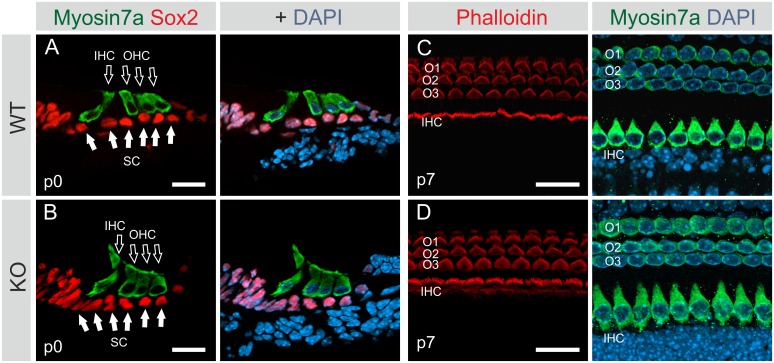
Phenotype of the early postnatal Bmi1 knockout organ of Corti.(A and B) Sections of the cochleae of WT (A) and KO (B) mice at p0, immunolabeled with Myosin7a (green) and Sox2 (red) and counterstained with DAPI (blue). Hollow white arrows mark inner and outer hair cells. Solid white arrows label supporting cells. Immunohistochemical analysis shows normal development of the Bmi1 KO OC, as determined by the expression of the hair cell marker Myosin7a and the supporting cell marker Sox2. (C and D) Surface views of the OC of WT (C) and KO (D) mice at p7, stained with phalloidin, which labels stereocilia, and Myosin7a, a hair cell marker. Nuclei were labeled with DAPI. Immunohistochemical analysis shows normal development of the Bmi1 KO OC. Both WT and KO mice possess three rows of outer hair cells (O1, O2 and O3) and one row of inner hair cells. Neither WT nor KO OC show disorganized structure or stereocilia abnormalities at p7. WT: wildtype, KO: knockout, IHC: inner hair cells, OHC: outer hair cells, SC: supporting cells. Scale: 20 μm.